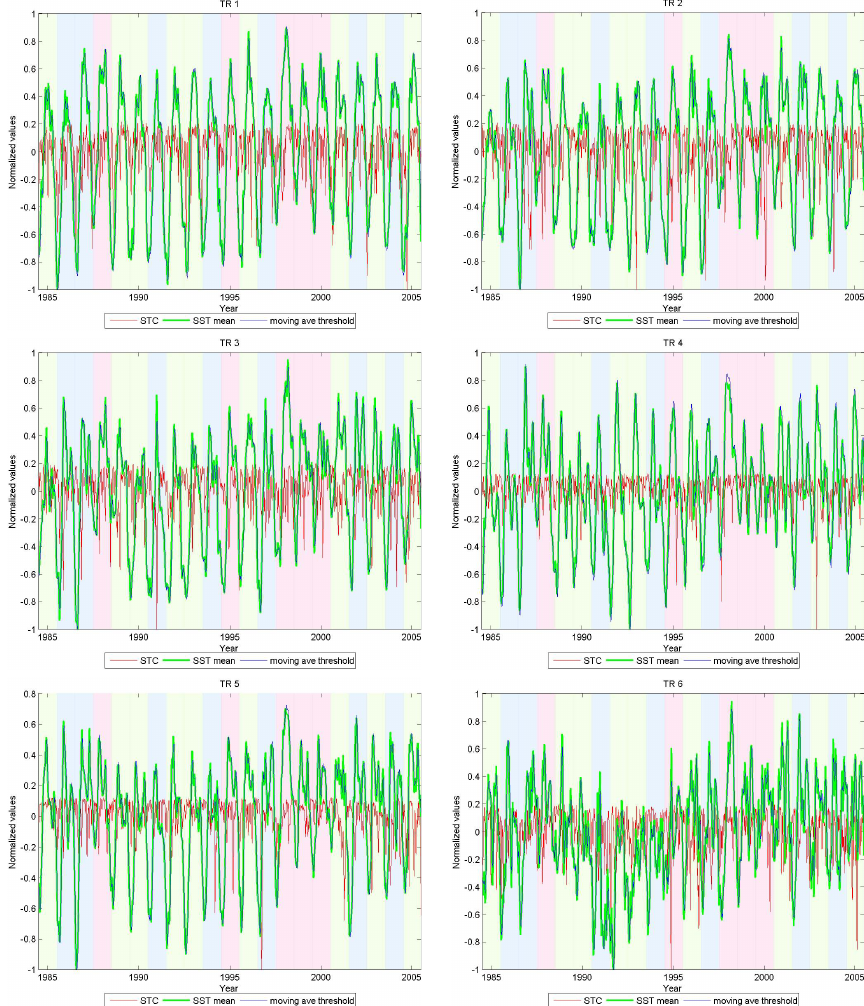
Fig. 13. The STC of each thermal region, plotted with the mean of the time slice used in computing the STC, and with the moving average threshold. The STC, slice window mean and the moving average threshold are fist mean-centered and then divided by their maximum to normalize the values. Overlapping time slices, s = 3, j = 2, c = 3. El Ni˜no years are highlighted in blue, La Ni˜na in red, and normal years in